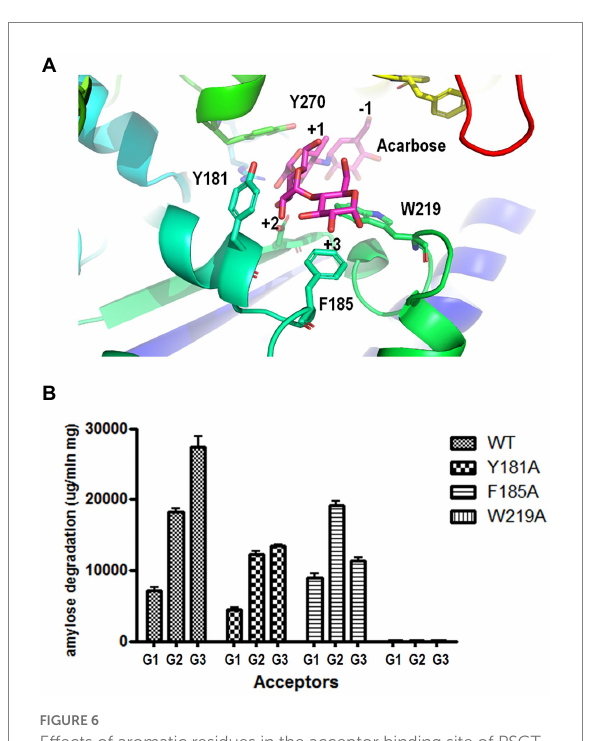
FIGURE 6 Effects of aromatic residues in the acceptor binding site of PSGT. (A) Structural model of PSGT superimposed with acarbose. (B) Amylose degradation activity of WT and mutant rPSGT in the presence of 5 mM glucose, maltose, or maltotriose as